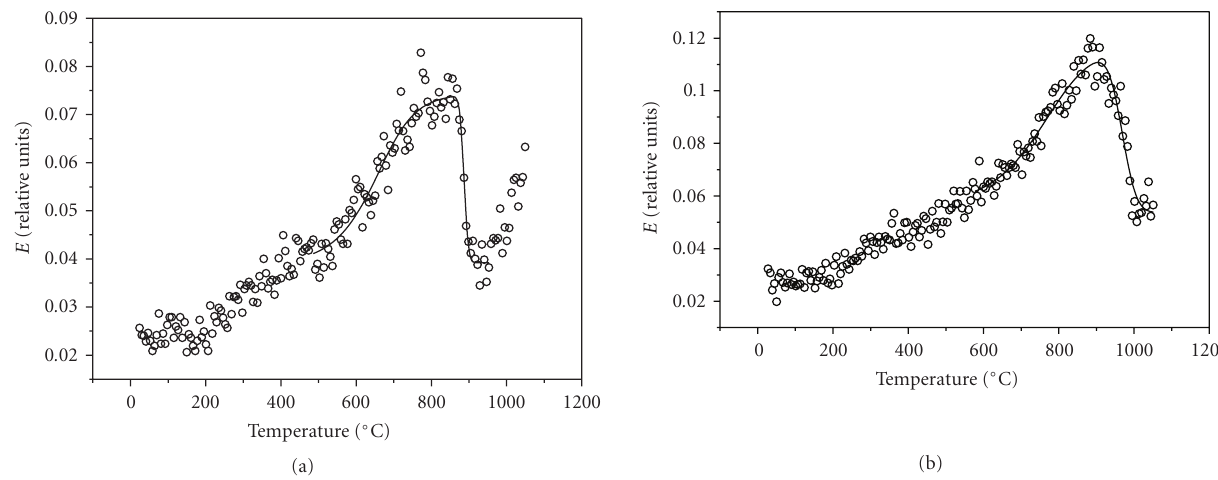
Figure 5: DSA experimental results (round points) and the results obtained by mathematical modeling and fitting with the experimental results (full lines) for the samples; (a) nondoped TiO 2 prepared from anatase ST 01, Ishihara Ltd., Japan, (b) sample B prepared by heating sample A in a flow of NH 3 at 575 ◦ C/3h.